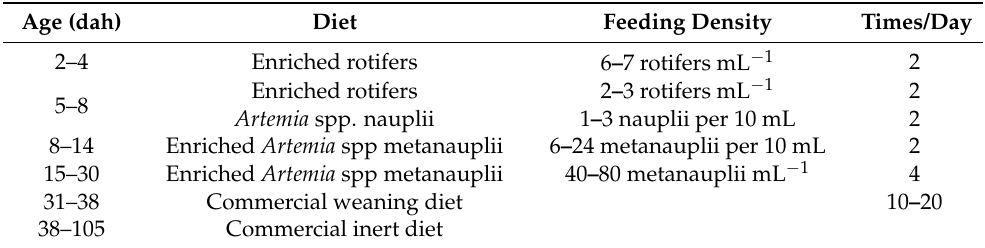
Table 2. Feeding regime during the experiment. Rotifers ( Brachionus plicatilis ) were enriched with mi- croalgae ( Isochrysis galbana ). Artemia spp. metanauplii were enriched with four different commercial products (EA, EB, EC, ED). Dah: days after hatching. Feeding Density